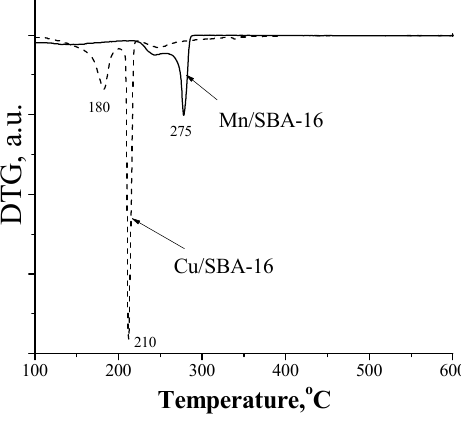
Figure 3. TPR of the Cu/SBA-16 and Mn/SBA-16 catalysts.